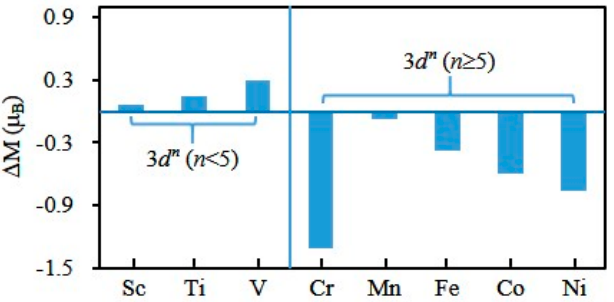
Figure 10. The magnetic moment of the free M atom as the reference point, the change of magnetic moments of the M atom in Cu 4 M (M = Sc-Ni) clusters.